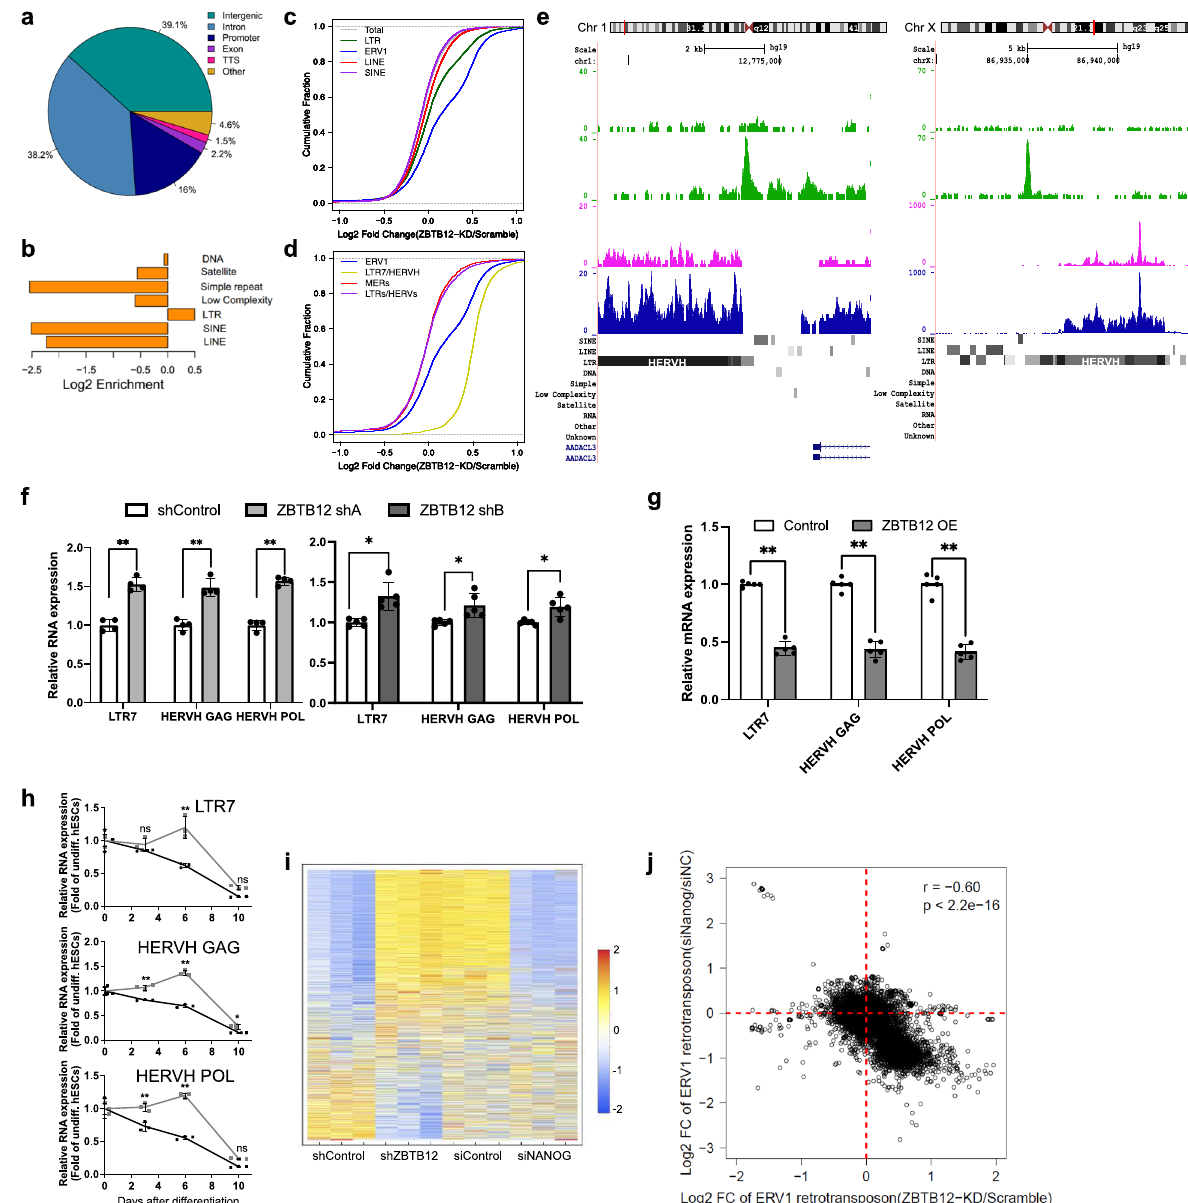
Fig. 4 | ZBTB12 fi ne-tunes the expression of transcriptionally active HERVH loci.a GenomiccategoriesofZBTB12bindingpeaks. b Signi fi cantLTRenrichment of ZBTB12 ChIP-seq peaks among repetitive elements. c Log2 Fold Change of ret- rotransposon subtypes including LINE ( D =0.070502, p -value<2.2e − 16), SINE ( D =0.014083, p -value=7.55e − 15), LTR ( D =0.16187, p -value<2.2e − 16), and ERV1 ( D =0.34723, p -value<2.2e − 16) after ZBTB12 knockdown (Kolmogorov – Smirnov (KS) test for each subtype compared to total background, n =284397 for Total; n =21267 for LTR; n =82450 for LINE; n =122210 for SINE; n =8223 for ERV1). d Log2 Fold Change of ERV1 ( D =0.31112, p -value<2.2e − 16) retrotransposon sub- types including LTR7/HERVH ( D =0.79215, p -value<2.2e − 16), MERs and other LTRs/HERVs ( D =0.028009, p -value=0.1319) after ZBTB12 knockdown (Kolmogorov – Smirnov (KS) test for each subtype compared to MERs subtype, n =8223 for ERV1; n =3085 for LTR7/HERVH; n =2529 for MERs; n =5138 for LTRs/